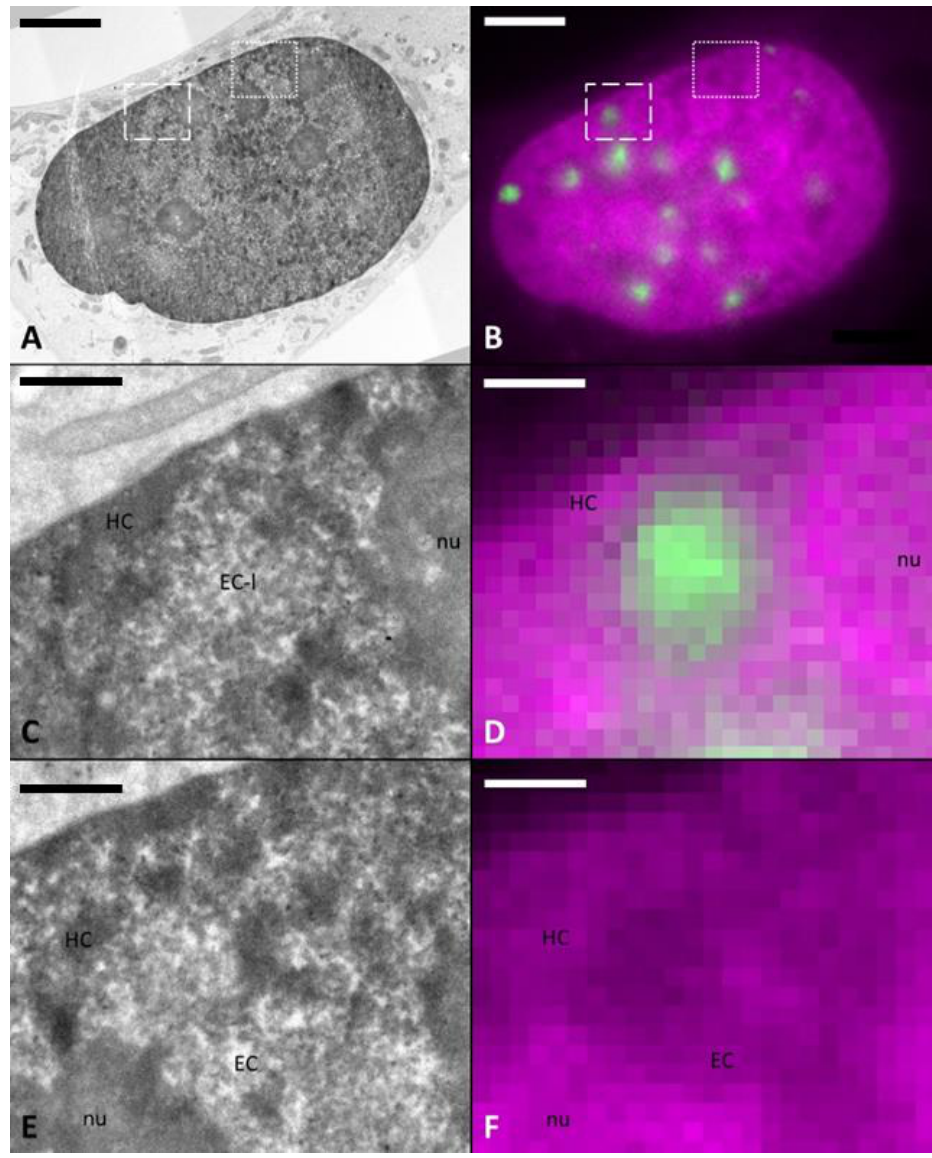
Figure 3. Absence of LDAs at damage site after chromatin-specific contrasting (ChromEMT). TEM image of a DNA-specific (ChromEMT) stained sample ( A ) correlated with FM image ( B ) with DNA (magenta) and 53BP1 (green). With ChromEMT staining, no LDA phenotype is visible. However, the irradiated area (dashed box) shows a structure ( C with correlated FM image ( D )) similar to euchromatin (EC) (doted box) of a non-irradiated area ( E , correlated FM image ( F )). Heterochromatin (HC) is clearly visible as more dark and dense structures mainly along the border of the nucleus and the nucleoli (nu) ( A , C , E ). Scale bar: A & B 5 µm, C – F 1 µm.